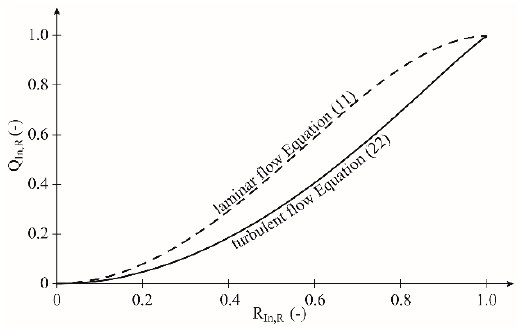
Figure 4. The relation of the integral relative flow discharge Q In and integral relative radius R In .